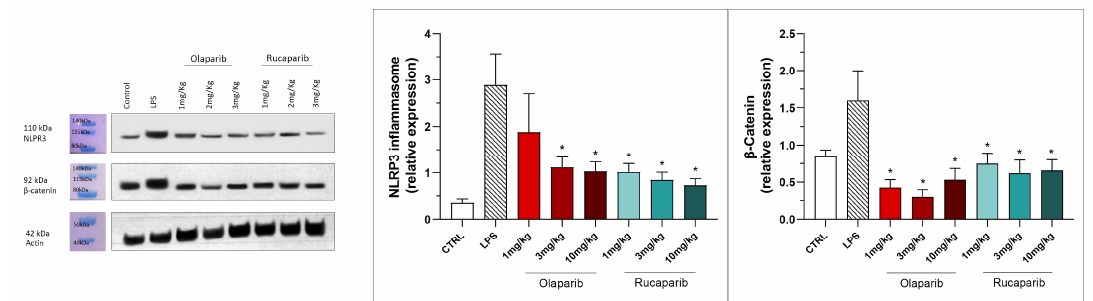
Figure 17. Effect of olaparib and rucaparib on NLPR3 inflammasome activation and β -catenin expression in the lung tissue in a murine model of ALI. C57Bl/6 mice received either PBS (30 µ L) or LPS (50 µ g in 30 µ L PBS) by intratracheal instillation in the absence or presence of various doses (1, 3, or 10 mg/kg) of olaparib or rucaparib. After 24 h, lungs were collected, and NLPR3 inflammasome activation and β -catenin expression were measured by Western blotting. * p < 0.05 indicates an inhibitory effect of the PARP inhibitors tested in LPS-treated animals. Data are shown as mean ± SEM, n = 8–12/group.